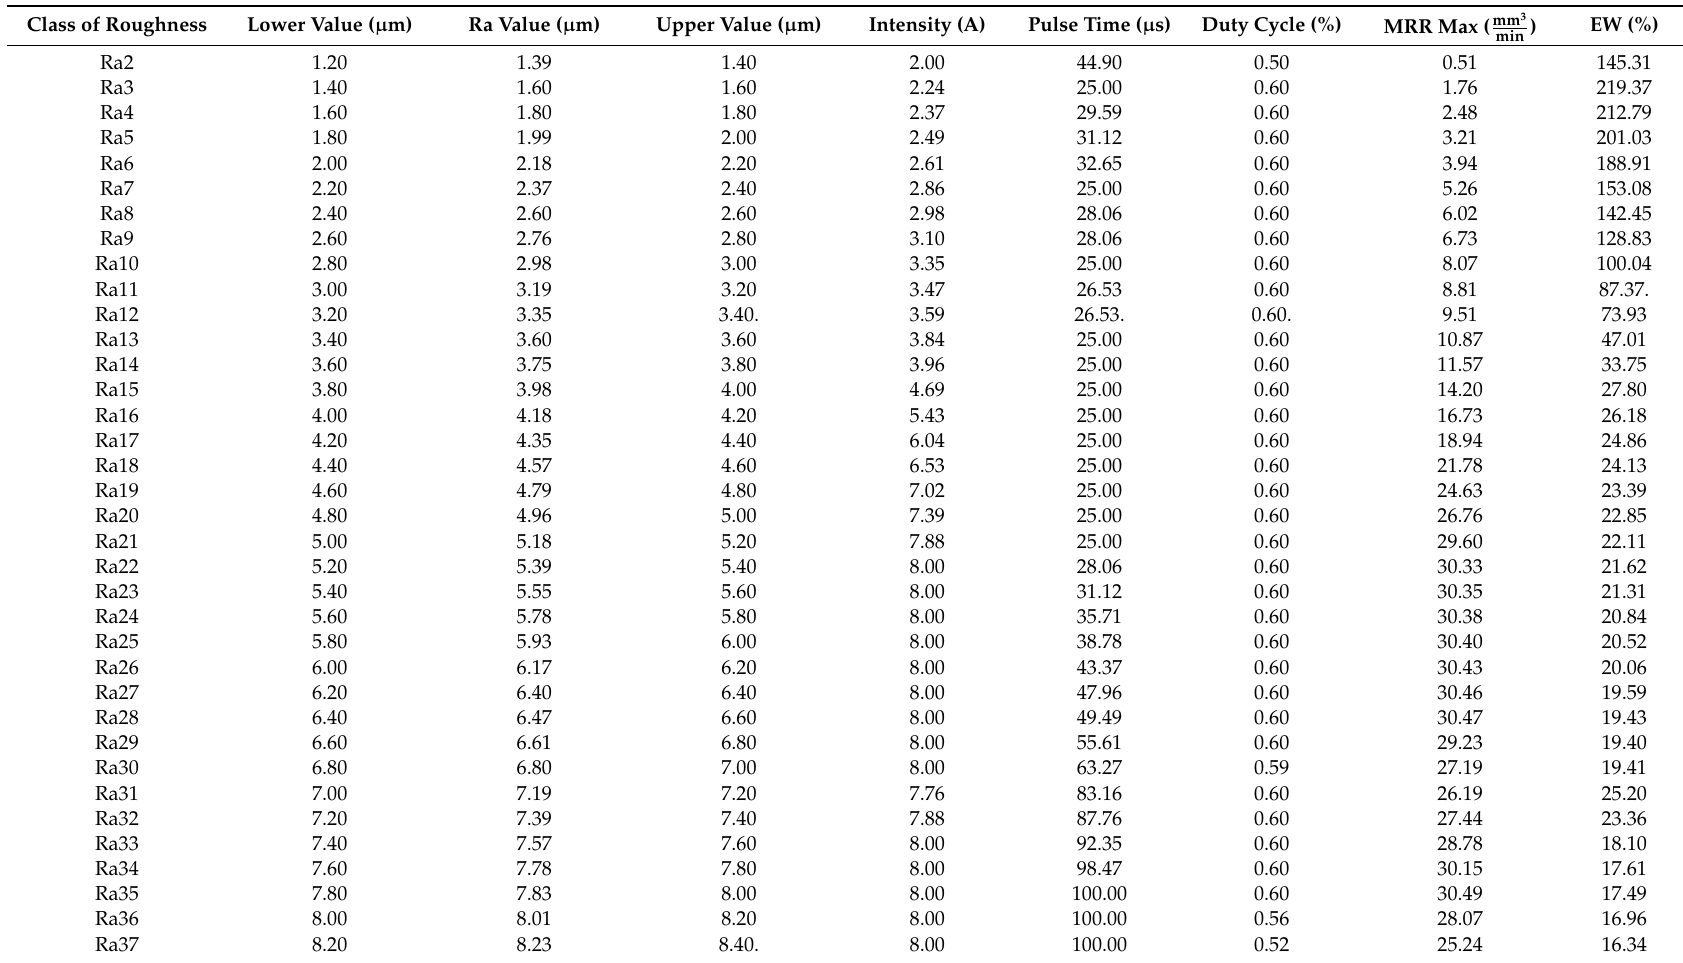
Table 7. Strategy of maximum material removal rate. Technological table obtained from the FIS, for the case of maximum removal rate strategy (negative